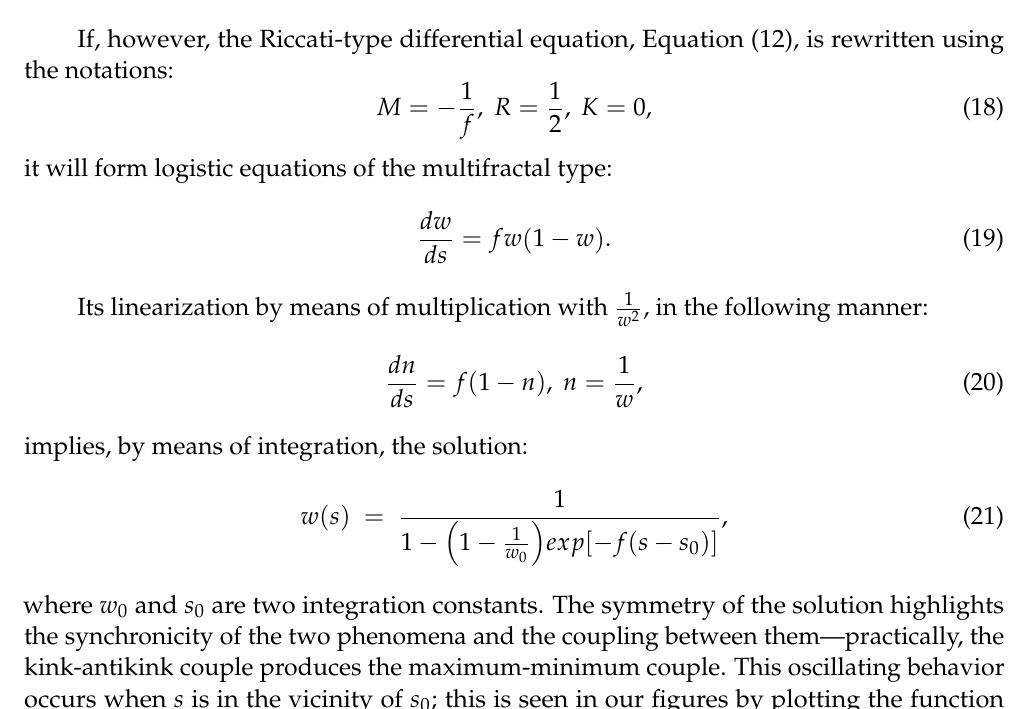
Figure 4. Plot of kink-antikink w ( s , R ) : ( a ) Kink, M = 200, K = 1; ( b ) Antikink, M = 200, K =